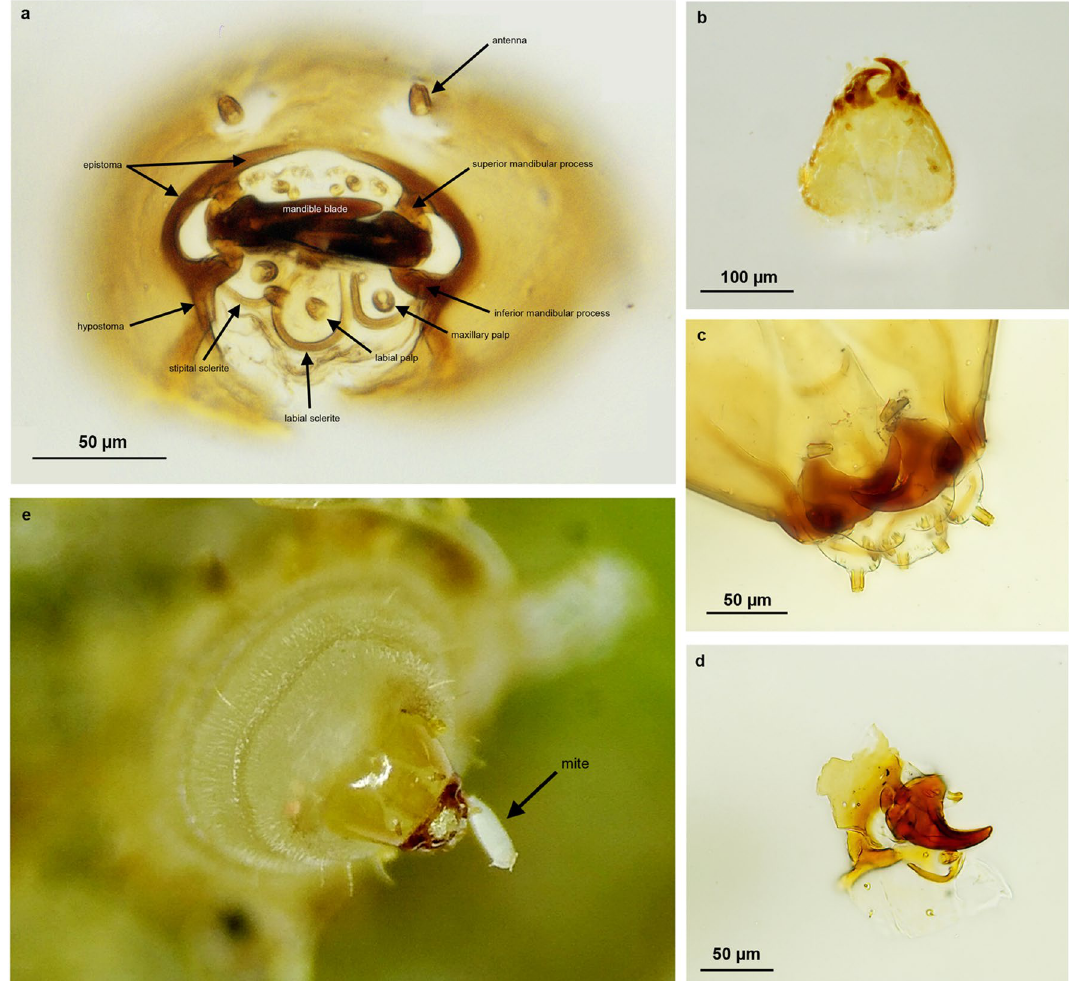
Figure 3. Final instar larval cephalic structure of Bracon predatorius Ranjith & Quicke sp. nov. (a–d ) Slide microphotographs of larval head capsule and mandible ( a ) macerated head capsule in anterior view, ( b ) head capsule, in dorsal view, ( c ) head capsule (in part), ventral view, ( d ) right mandible, in dorsal view, ( e ) anterior view of living final instar larva of B. predatorius consuming